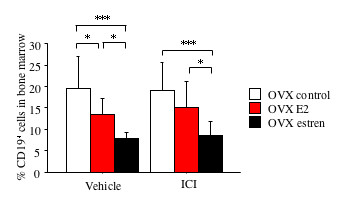
Estren reduces the frequency of CD19+ B cells in bone marrow independently of estrogen receptors. Ovariectomized 3-month-old female C57/B16 mice were treated for 18–21 days with daily s.c. injections of the estrogen receptor antagonist ICI 182,780 (200 μg/day) or vehicle Miglyol 812. Simultaneously, both the vehicle and the ICI groups were given daily s.c injections of either E2 (0.7 μg/day), estren (75 μg/day) or control Miglyol 812 oil. ICI 182,780 blocked the inhibitory effect of E2 on the frequency of CD19+ B cells in bone marrow. Treatment with estren resulted in lower frequency of CD19+ B cells in bone marrow in both vehicle and ICI mice. One-way ANOVA followed by Fisher's test was used to compare data from mice in different treatment groups. Results are presented as mean ± standard deviation. * P < 0.05, *** P < 0.001.